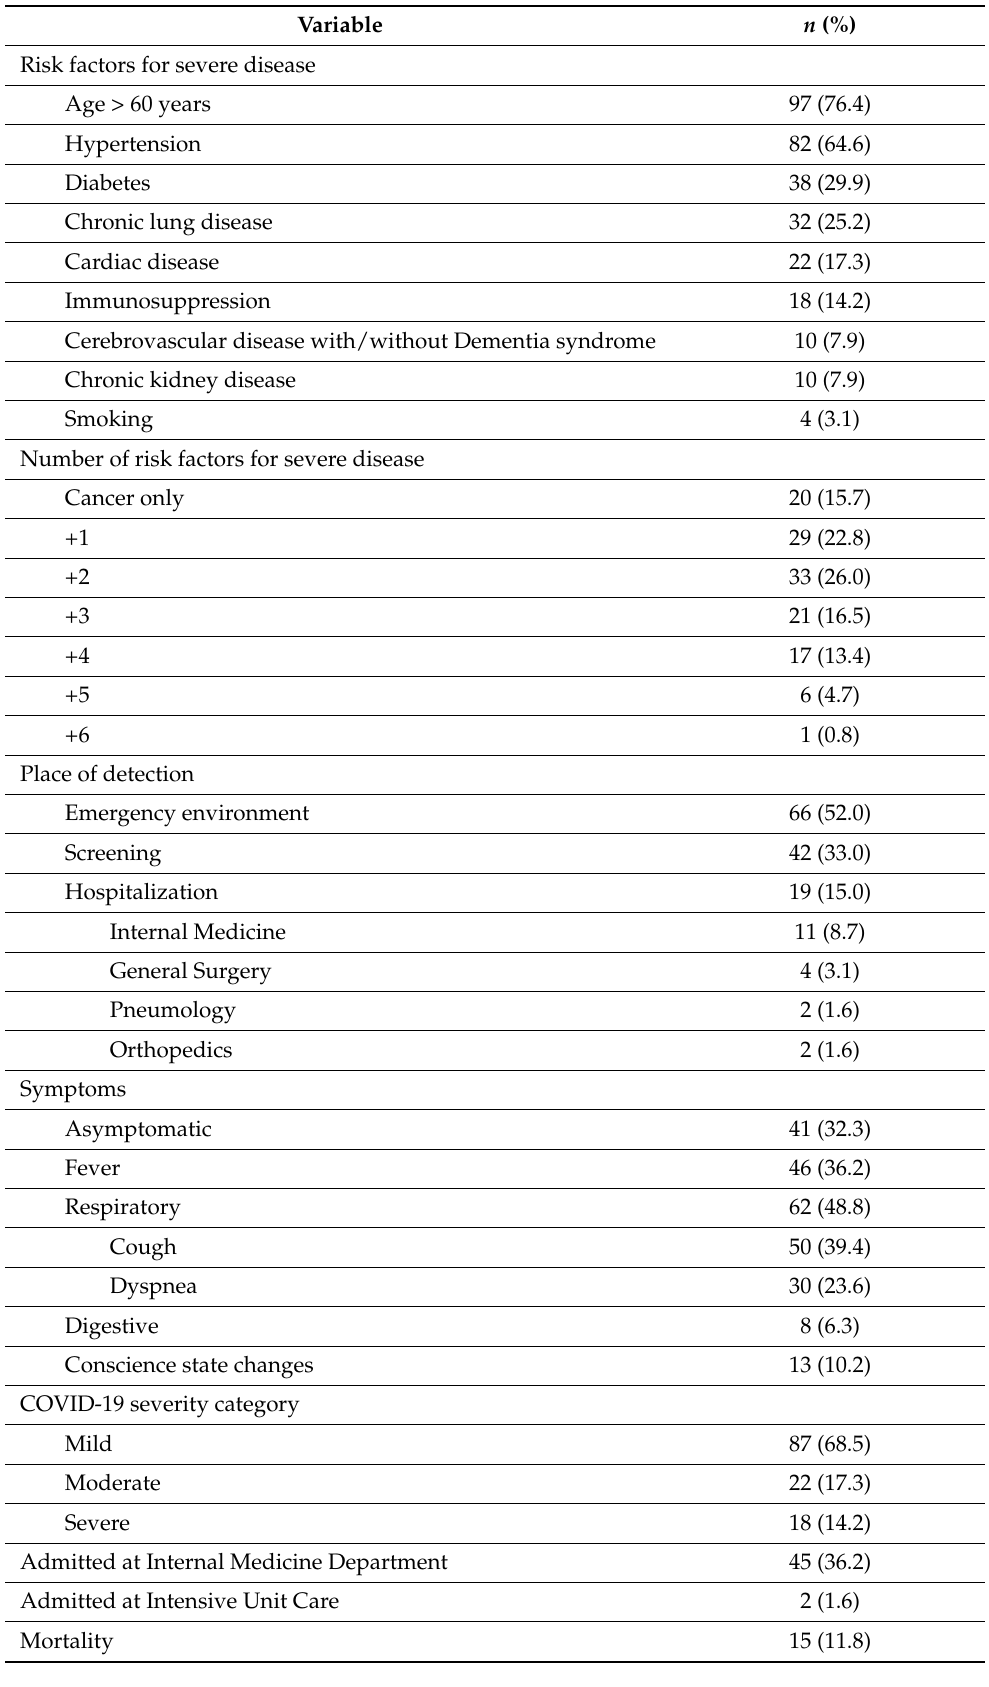
Table 2. Clinicopathological characteristics of COVID-19